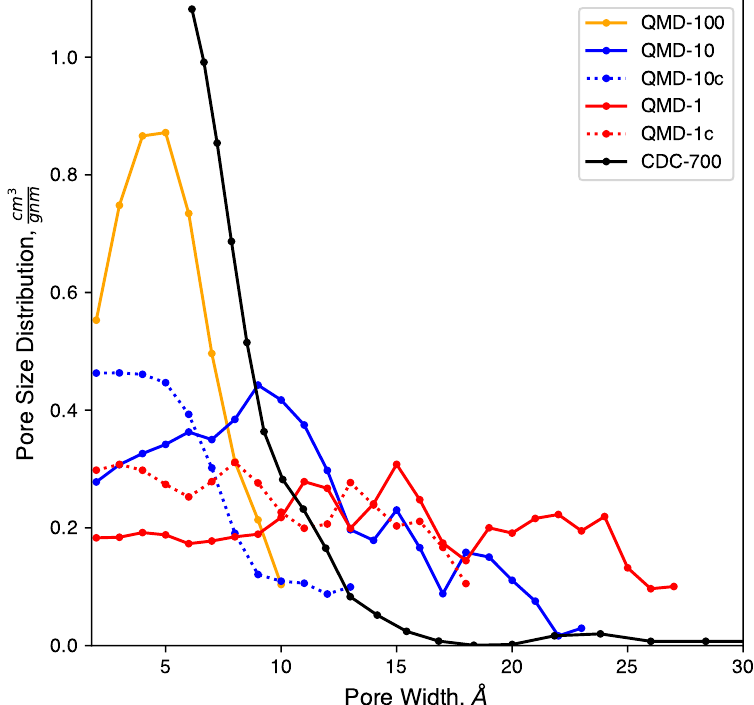
Figure 3. Pore size distributions of model samples compared to experiments.